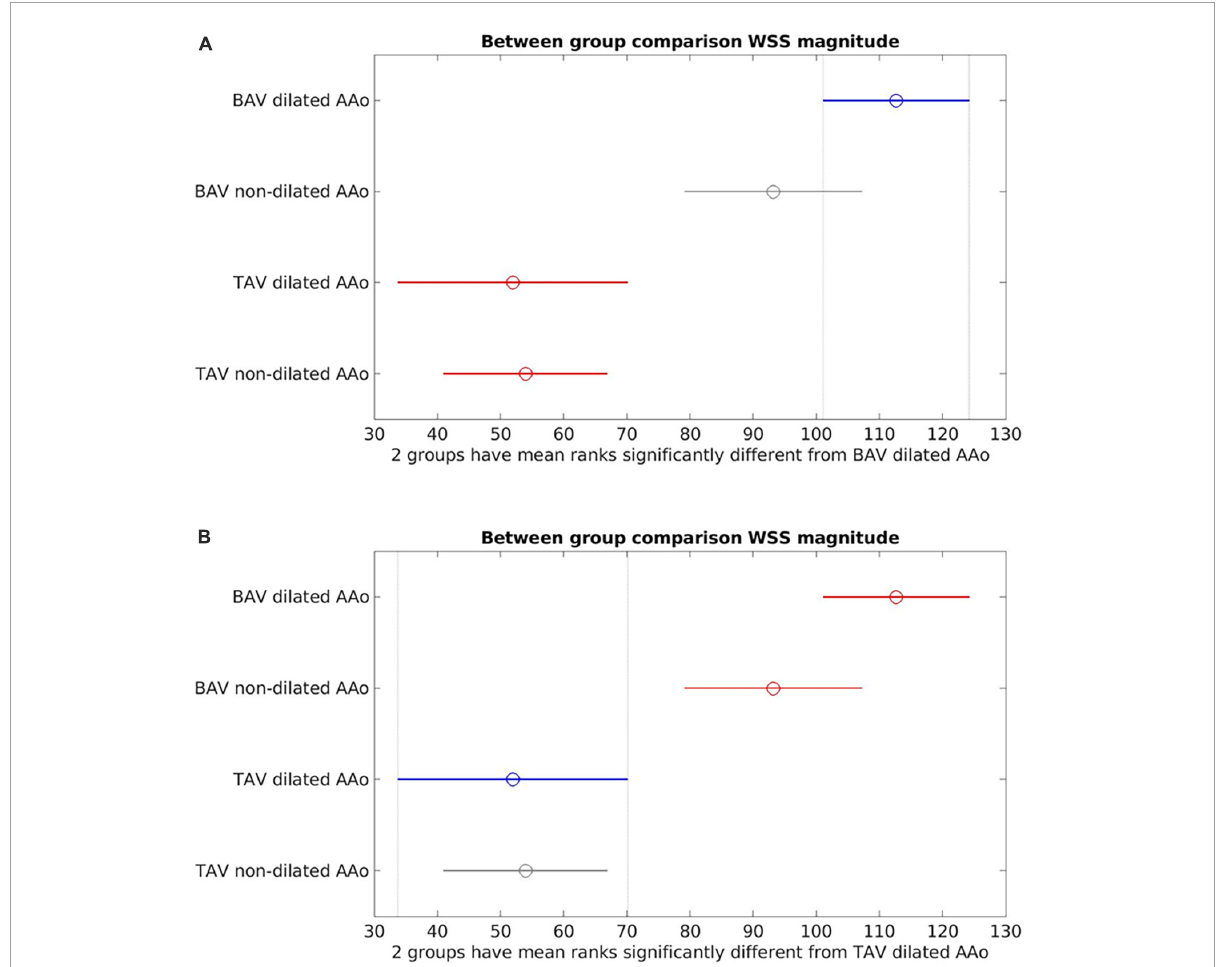
FIGURE4 Between-group comparisons of bicuspid aortic valve (BAV) dilated ascending aorta (AAo), BAV non-dilated AAo, tricuspid aortic valve (TAV) dilated AAo and TAV non-dilated AAo. (A) Bicuspid aortic valve (BAV) dilated is the reference cohort (blue). No statistically significant difference between BAV dilated and BAV non-dilated (gray). There were statistically significant differences between BAV dilated and the TAV cohorts (red); (B) TAV dilated is the reference cohort (blue). No statistically significant differences between TAV dilated and TAV non-dilated (gray). Statistically significant difference was present between TAV dilated and the BAV cohorts